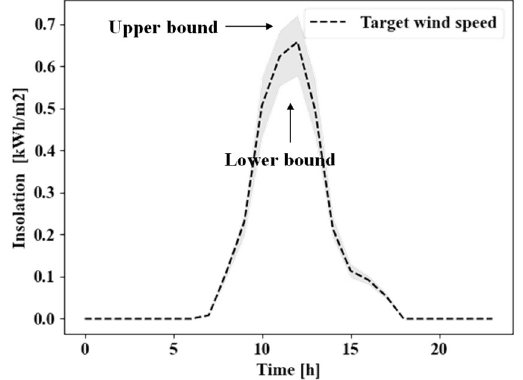
Figure 3. Insolation in Aewol-eup considering uncertainty of wind speed data.